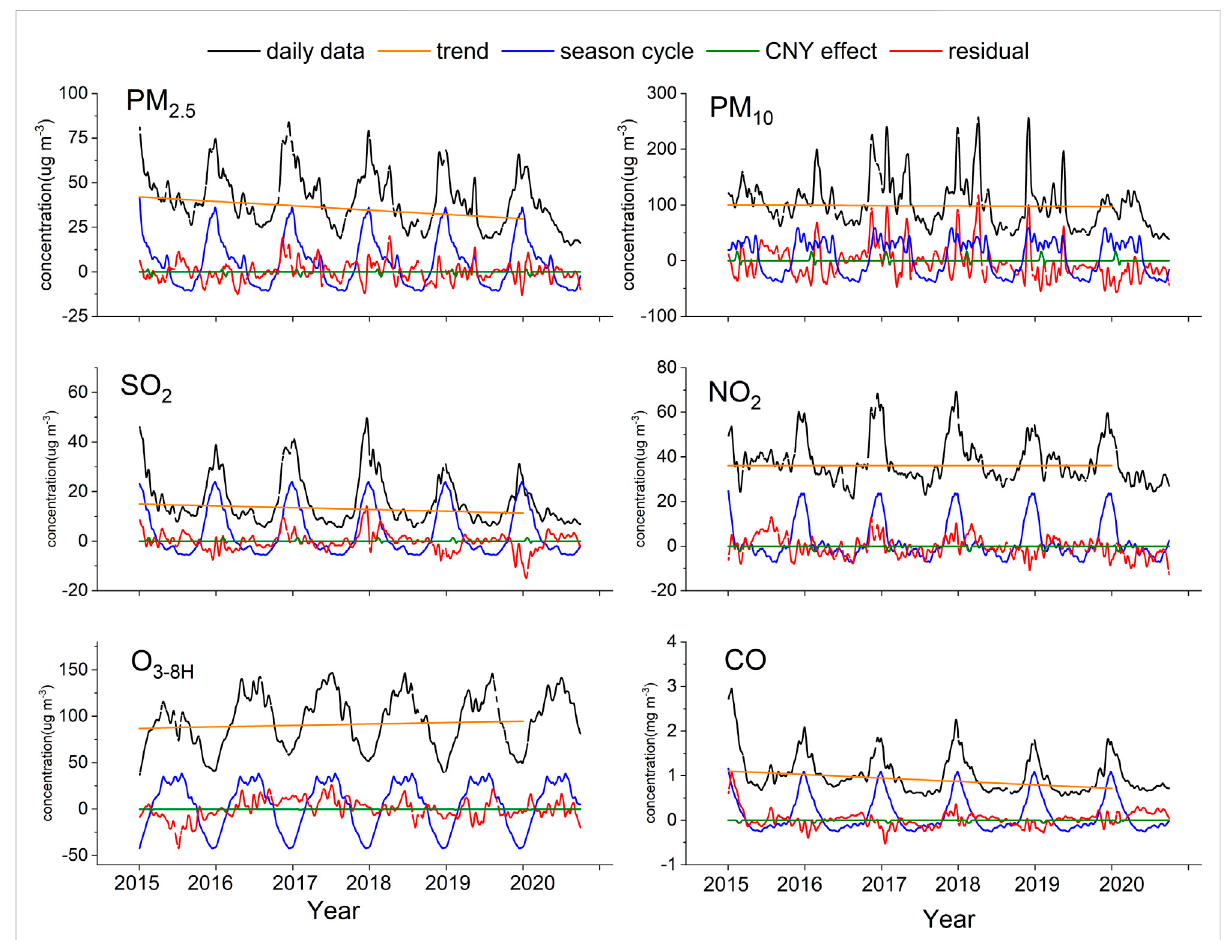
Dailytimeseriesforsixpollutants(black),decomposedintothetrend(orange),seasonalcycle(blue),ChineseNewYear(CNY)effect(green)and residual (red) components. The data are smoothed using a LOWESS fi